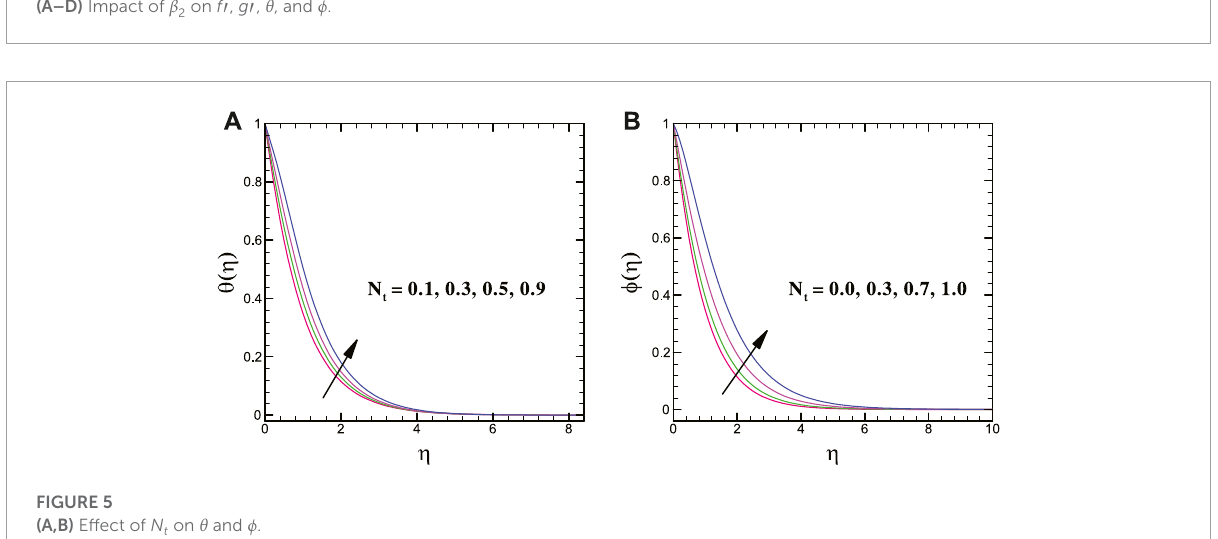
FIGURE 4 (A–D) Impact of β 2 on f ′ , g ′ , θ , and ϕ .